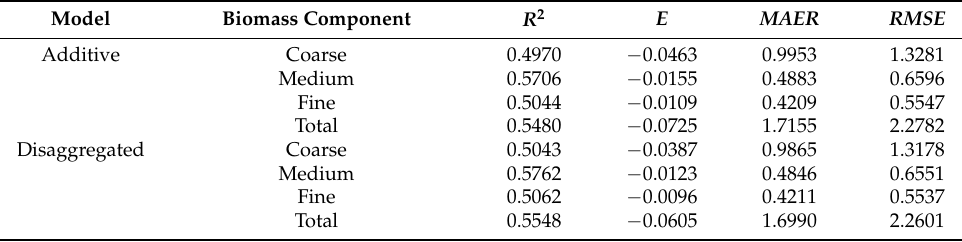
Table 7. Ten-fold cross-validation results for each root biomass component in the biomass equa- tion